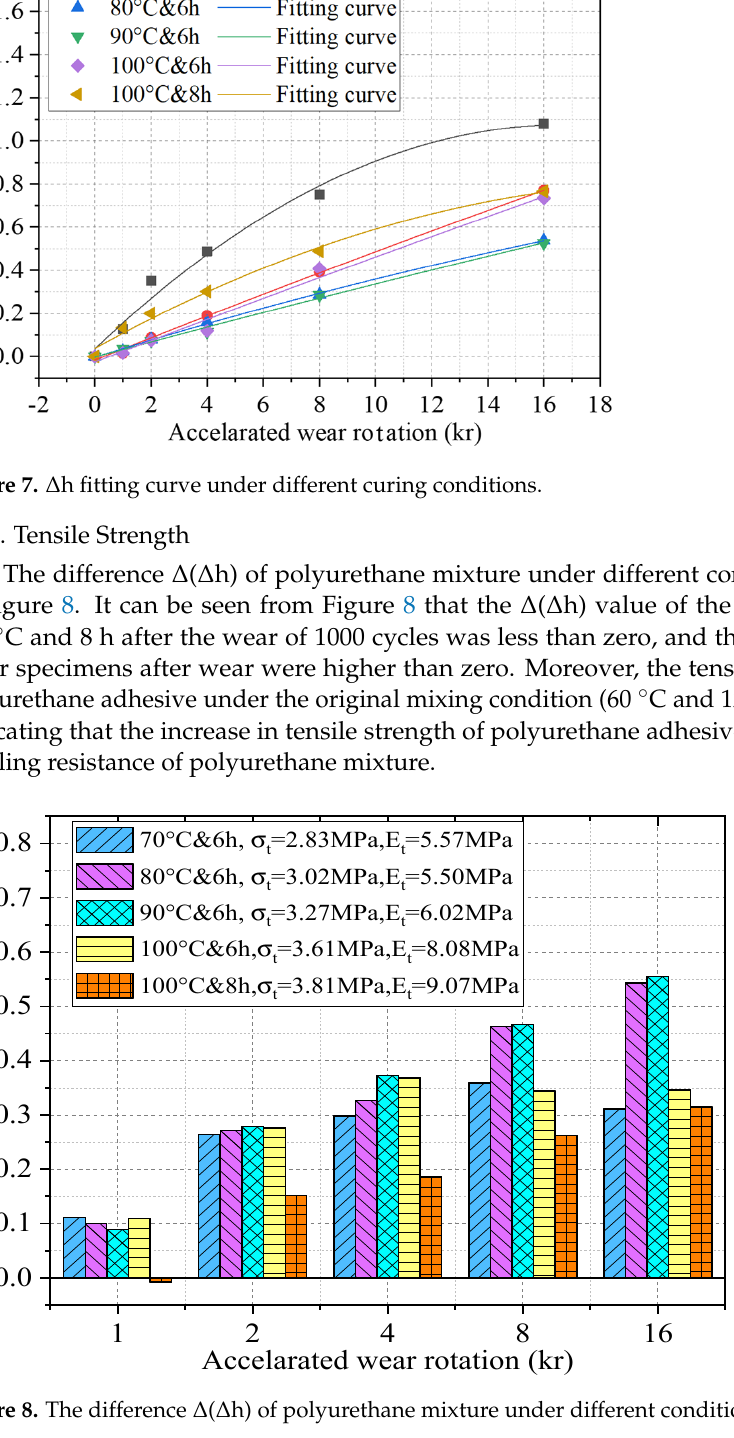
At the same time, by comparing the Δ ( Δ h) of different specimens under the same